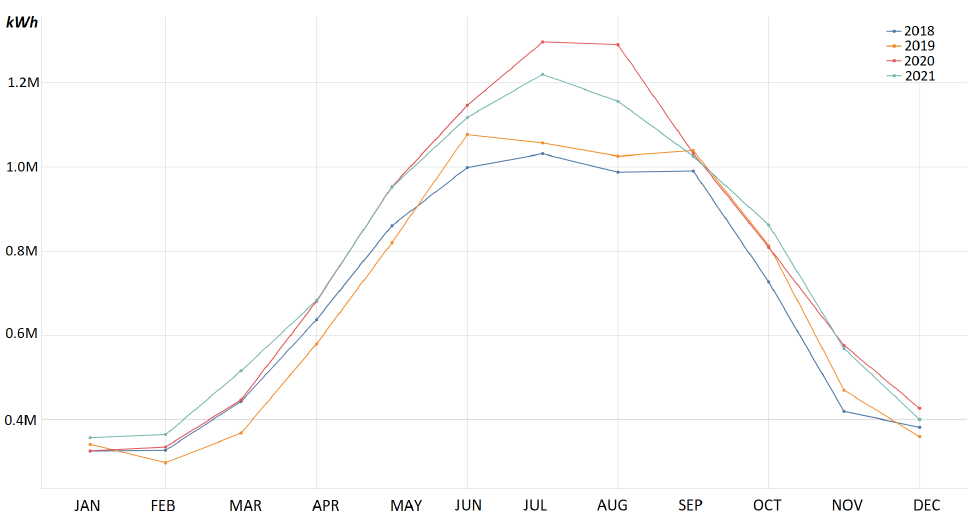
Figure 1. Total consumption for sample users in Dubai since